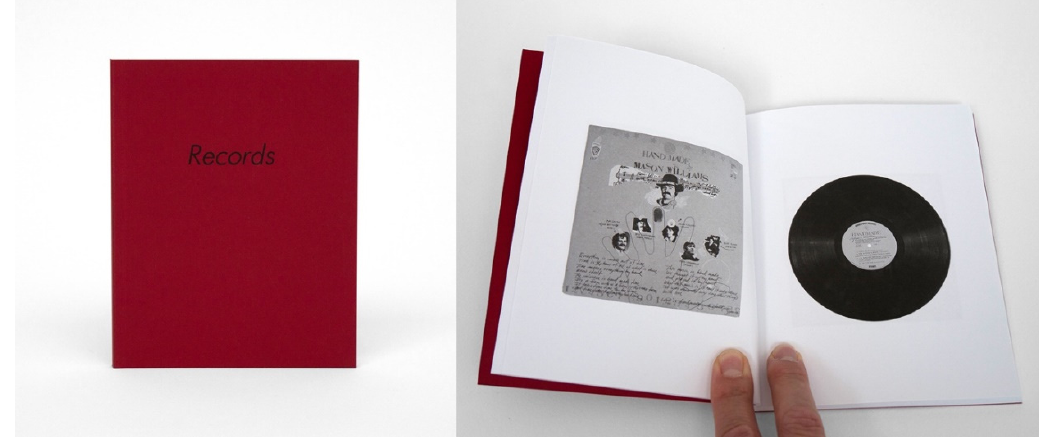
Figure 25. Eric Doeringer, Records , 2011.